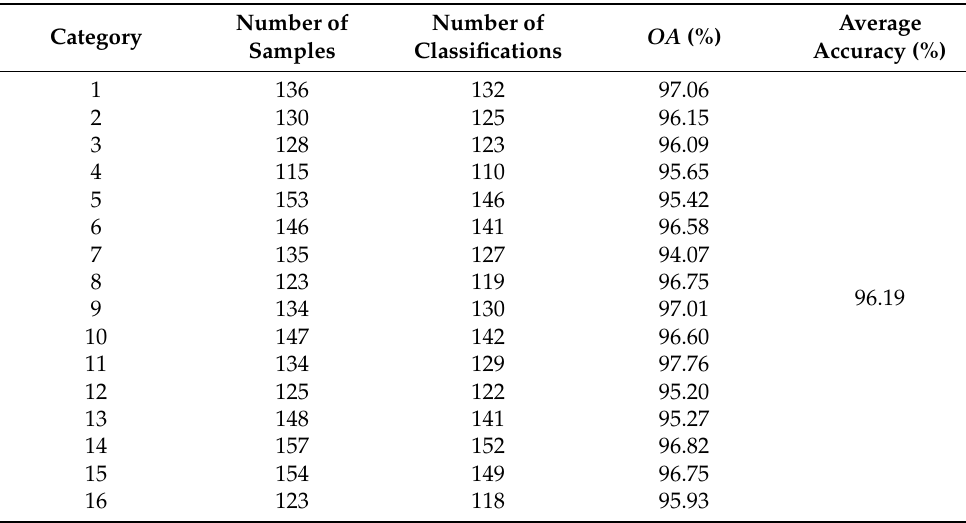
Table 6. The numbers and accuracies of the data classification